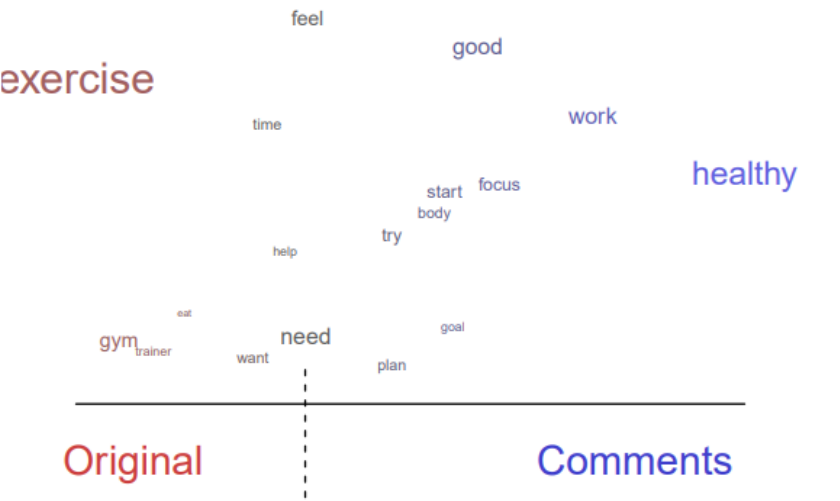
Figure 3. Difference in topic content between original threads and comments (communication: Topic 8).